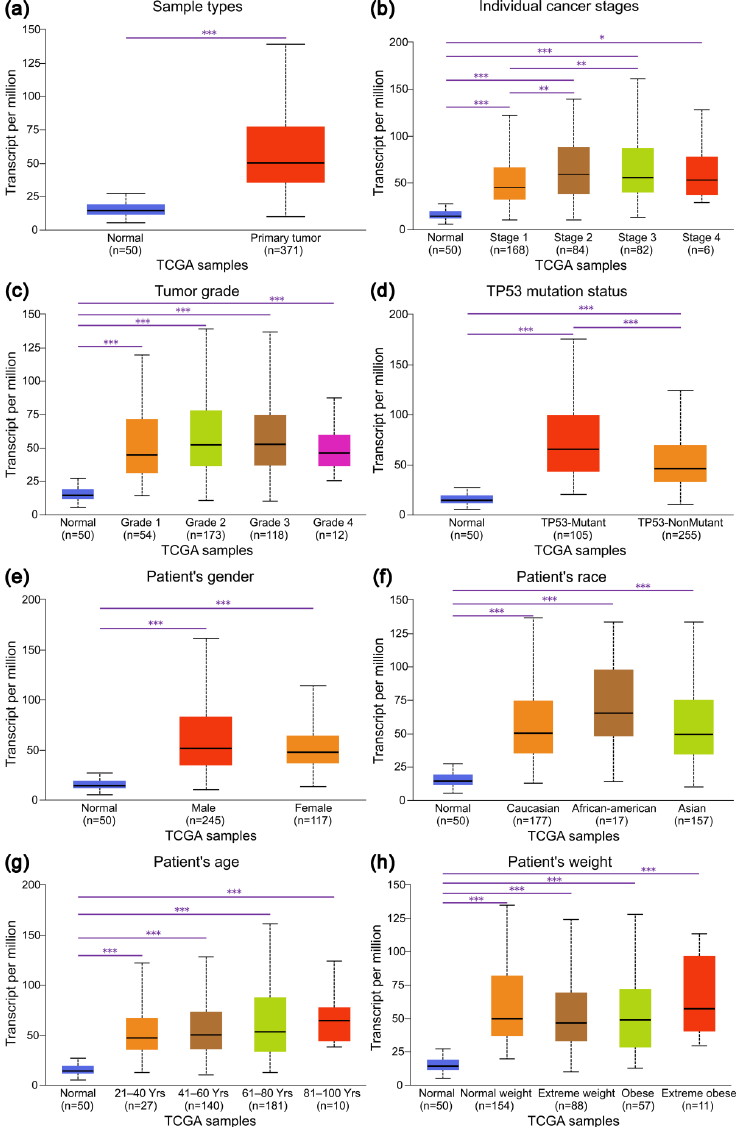
Figure 2. The expression levels of IRAK1 in hepatocellular carcinoma based on sample types and clinicopathological parameters. ( a ) Sample types; ( b ) individual cancer stages; ( c ) tumor grades; ( d ) TP53 mutation status; ( e ) gender; ( f ) race; ( g ) age; ( h ) weight. The statistical significance is annotated as * ( p < 0.05), ** ( p < 0.01), and *** ( p < 0.001). Moreover, there seemed to be no significant variations in IRAK1 expression with pa- thology T, N and M stages, or radiation therapy status (all p > 0.05; Figure 3a – d).